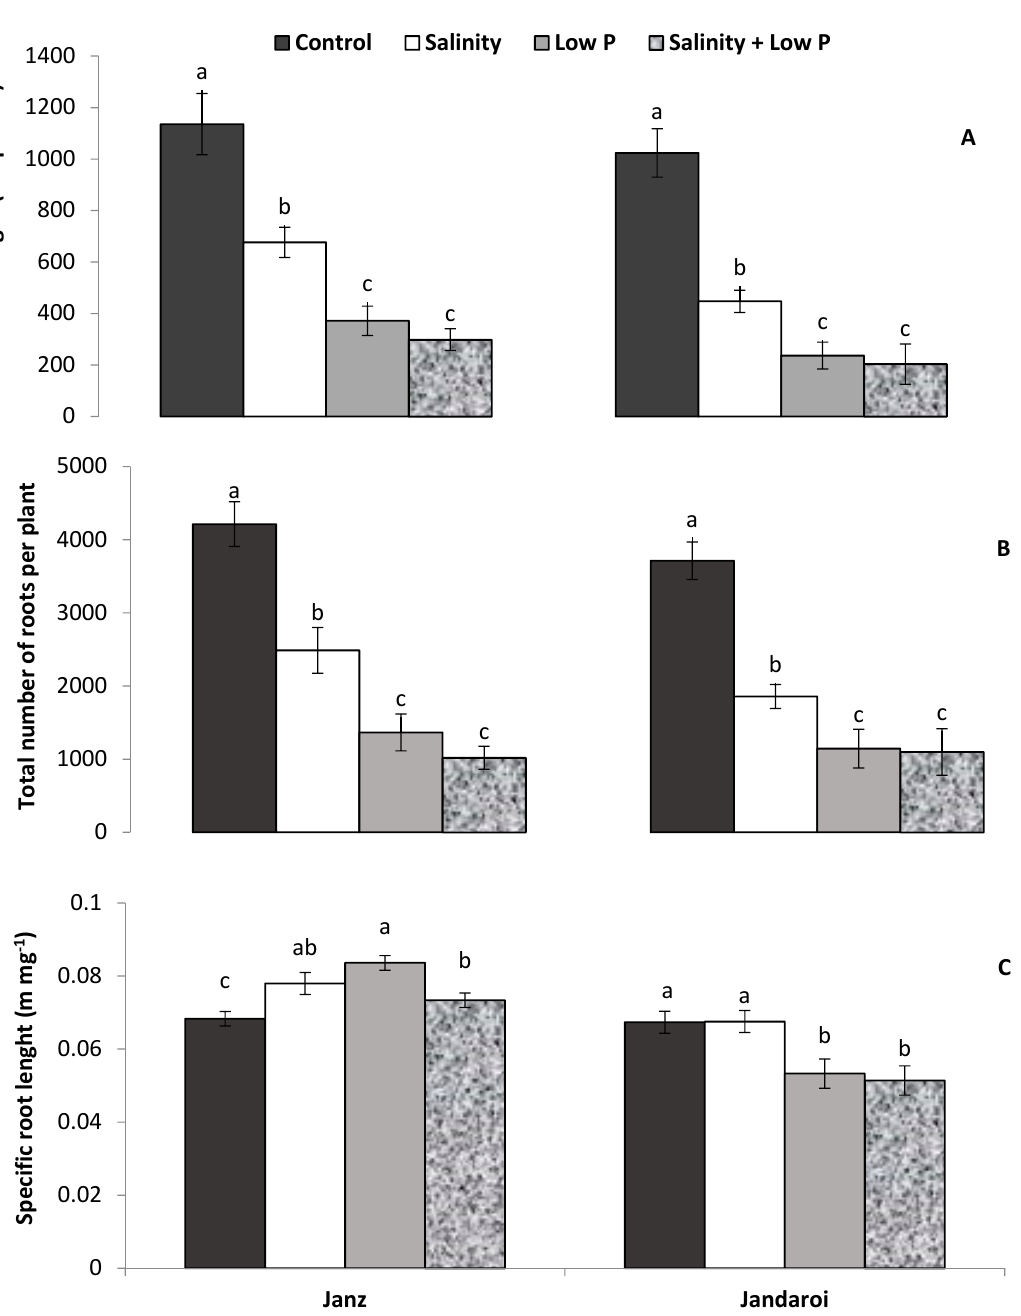
Figure 5. Effects of salinity, low P supply and their interaction on ( A ) total root length ( B ), total root number, and ( C ) specific root length of salt-tolerant (Janz) and salt-sensitive (Jandaroi) wheat cultivars. Measurements were made at the end of the experiment (40 DAS). Values are the means ± SE of three replicates (nine plants). For each cultivar, values sharing the same letter are not significantly different ( p ≤ 0.05).